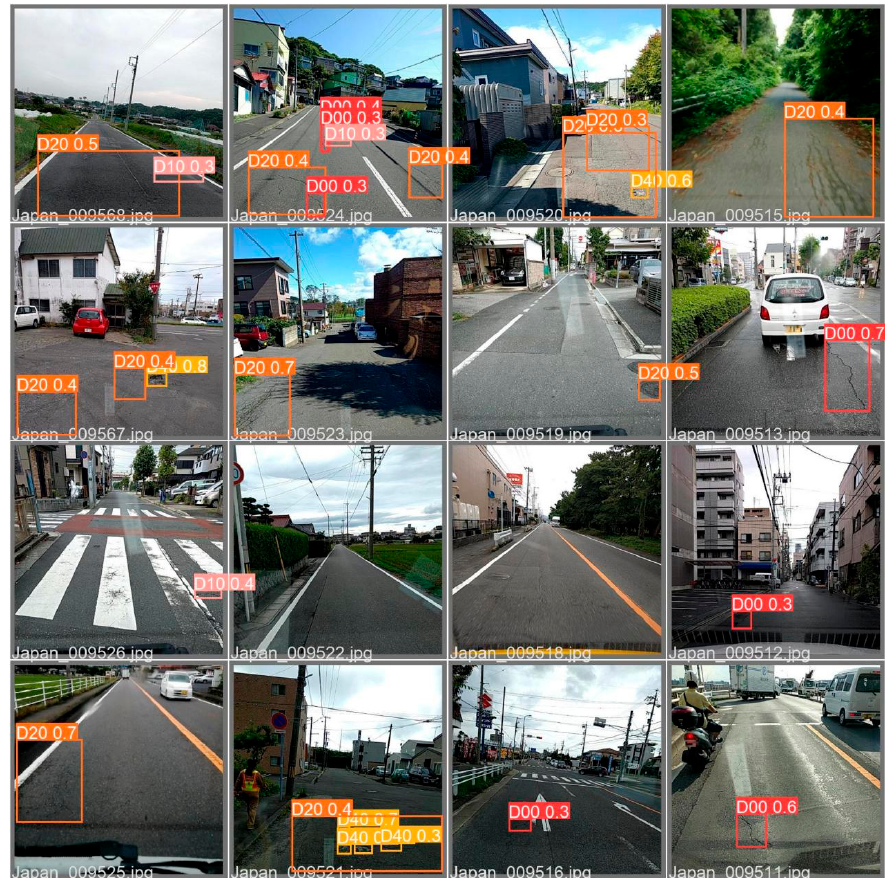
Figure 17. Pictures of detection results.